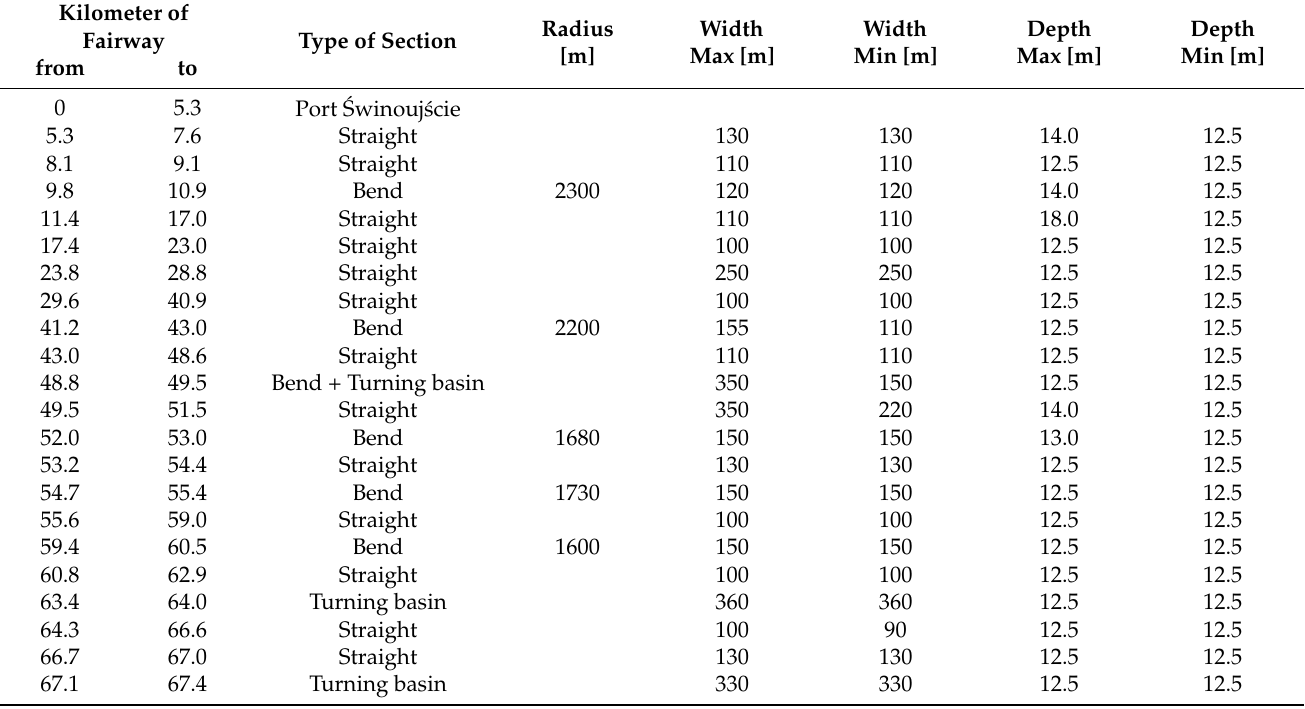
Table 1. Sections and the parameters of the modernized ´Swinouj´scie–Szczecin